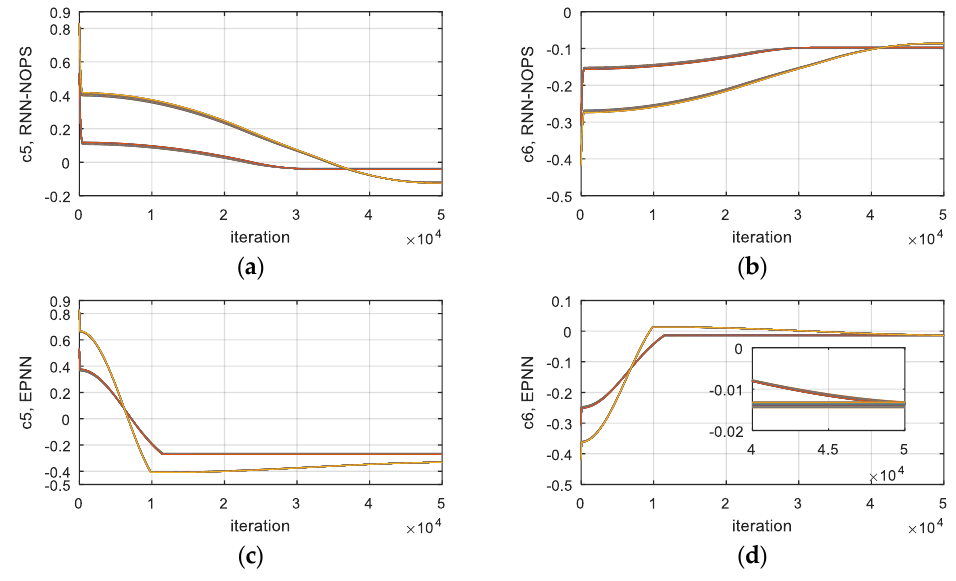
Figure 4. () c x and () c x ’s trajectories of ( a ), ( b ) RNN-NOPS and ( c ), ( d ) EPNN, respectively. Figure 4. c 5 ( x ) and c 6 ( x ) ’s trajectories of ( a ), ( b ) RNN-NOPS and ( c , d ) EPNN, respectively. 5 6 Overall results during the designed braking process are shown in Table 3, where it is shown that all the constraints are perfectly obeyed by both algorithms. With regard to the overall regenerative energy, RNN-NOPS recovers 6.77% more energy than Table 3. Overall results under the designed braking process in terms of regenerative energy and constraint violation.